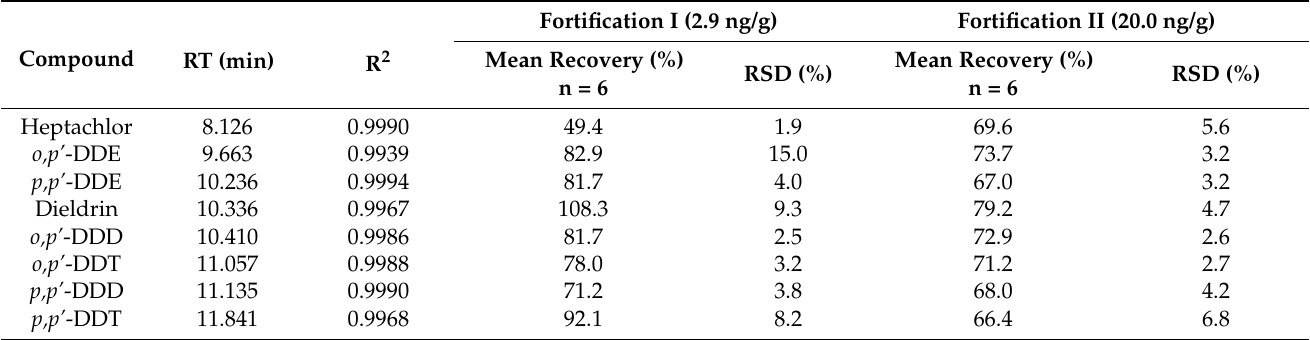
Table 1. Analyst 1 method validation